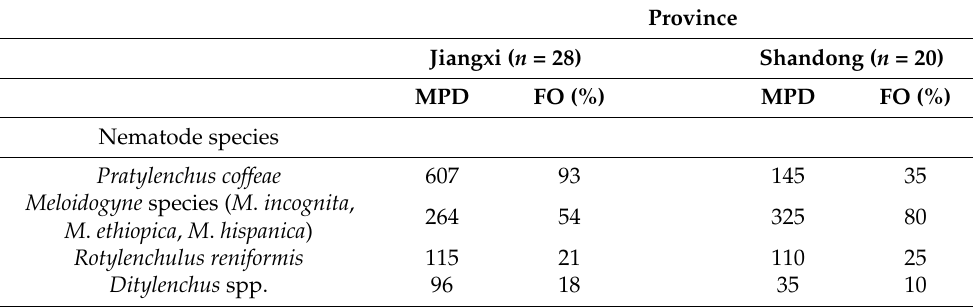
Table 3. Mean population densities (MPD) and frequencies of occurrence (FO %) of plant-parasitic nematodes species isolated from 5 g of yam roots/tubers from nine locations of Jiangxi and Shandong provinces of south-east China during